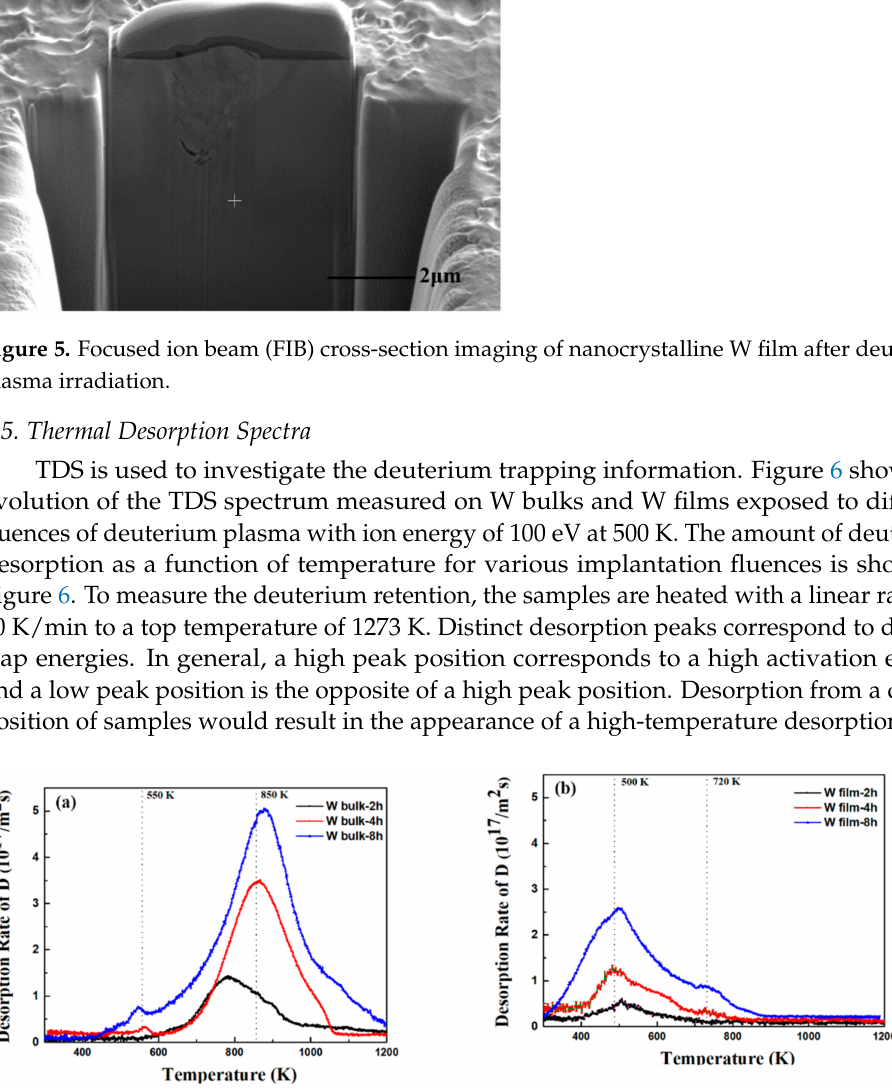
Figure 6. Thermal desorption spectroscopy (TDS) spectra of D 2 release in ( a ) W bulks and ( b ) W films exposed to 100 eV deuterium plasma at different irradiation